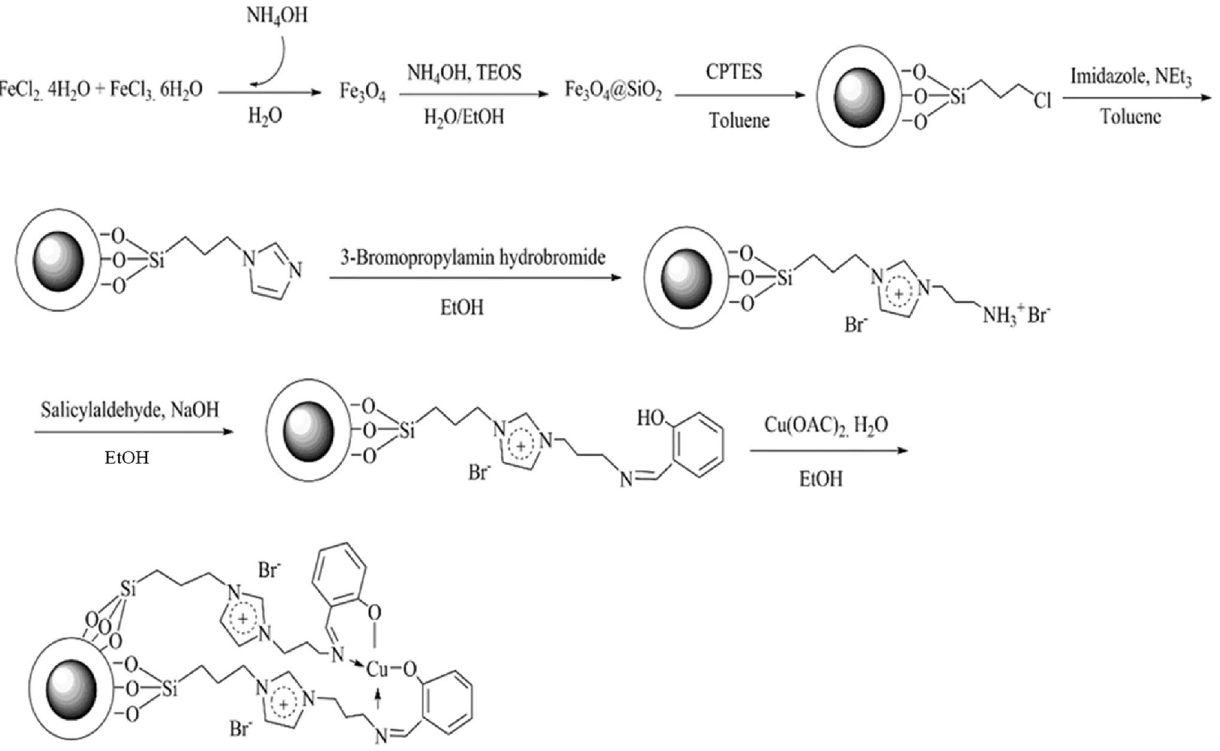
Figure 1. Synthesis of Fe 3 O 4 @SiO 2 -Im[Br]-SB-Cu (II) nano-catalyst.